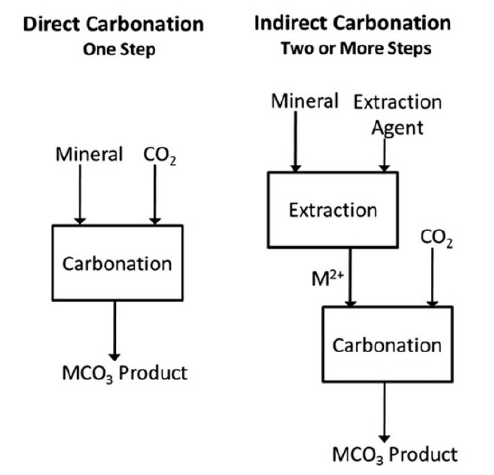
Figure 1. Direct (one step) mineral carbonation (left), and indirect (two or more steps) mineral carbonation (right); M refers to either calcium or magnesium. Reprinted from Progress in Energy and Combustion Science, Vol. 38, Bobicki et al. [24], 302-320, Copyright 2011, with permission from